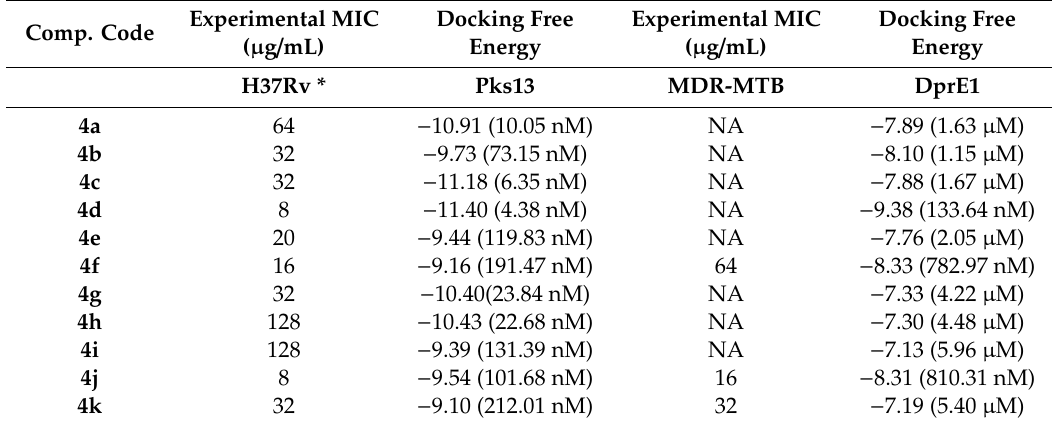
Table 3. Docking free energy (kcal / mol) and inhibition constant K i of target compounds 4a – k . Comp. Code